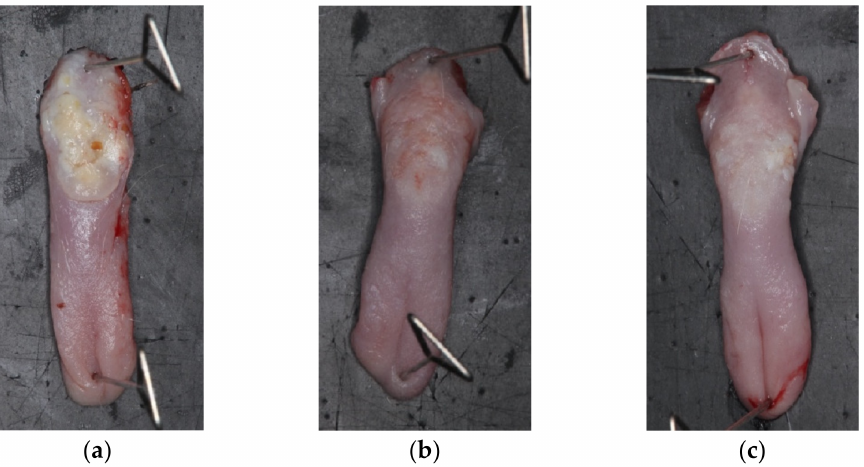
Figure 8. Excised tongue specimens from each group: ( a ) CTRL group; ( b ) Film group; ( c ) Film group (tumor at the left lateral border of the